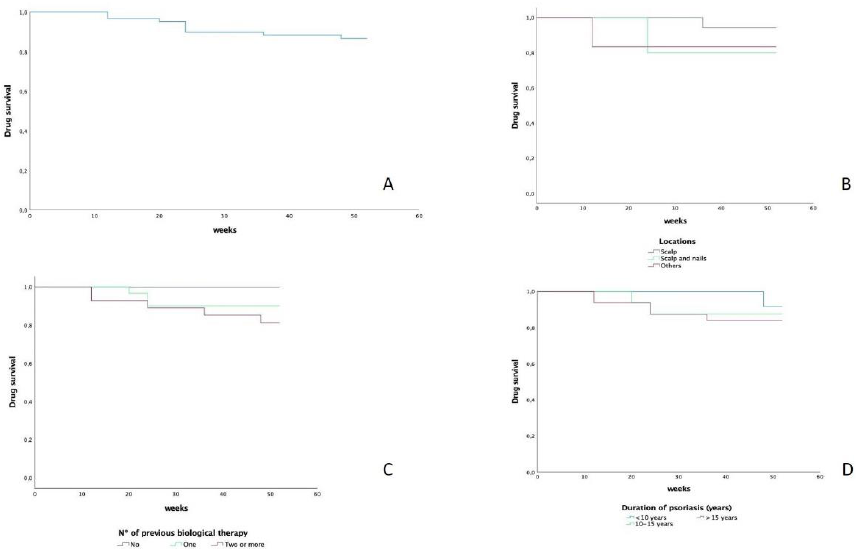
Figure 1. ( A ). Survival of tildrakizumab in a 52w period. ( B ). Survival regarding locations of psori- asis. ( C ). Survival regarding previous lines of treatment. ( D ). Survival regarding time duration of